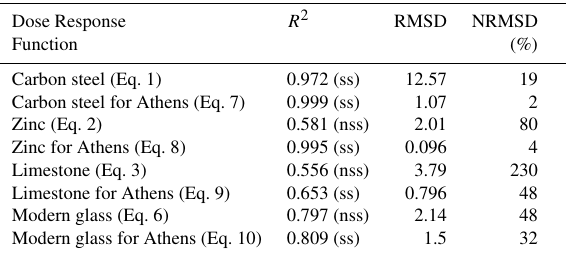
Table 2. Correlation coefficients R 2 , root mean square deviations (RMSDs) and normalised root mean square deviations (NRMSDs) between observed and predicted values for Athens, Greece. The abbreviation “nss” declares a non-statistically-significant value at a 95% confidence interval while “ss” is a statistically significant value at a 95% confidence